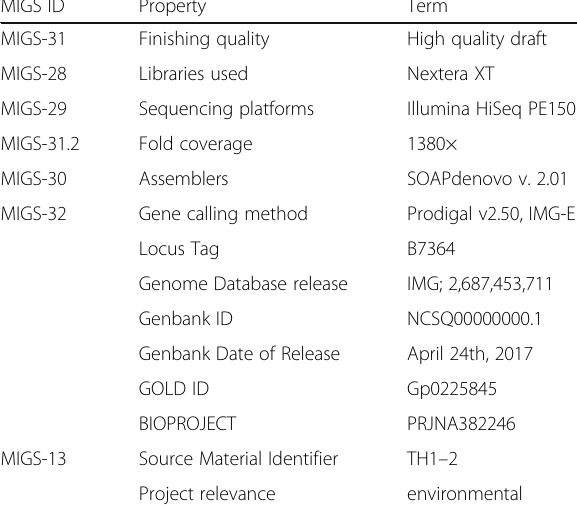
Table 4 Number of genes associated with the general COG functional categories